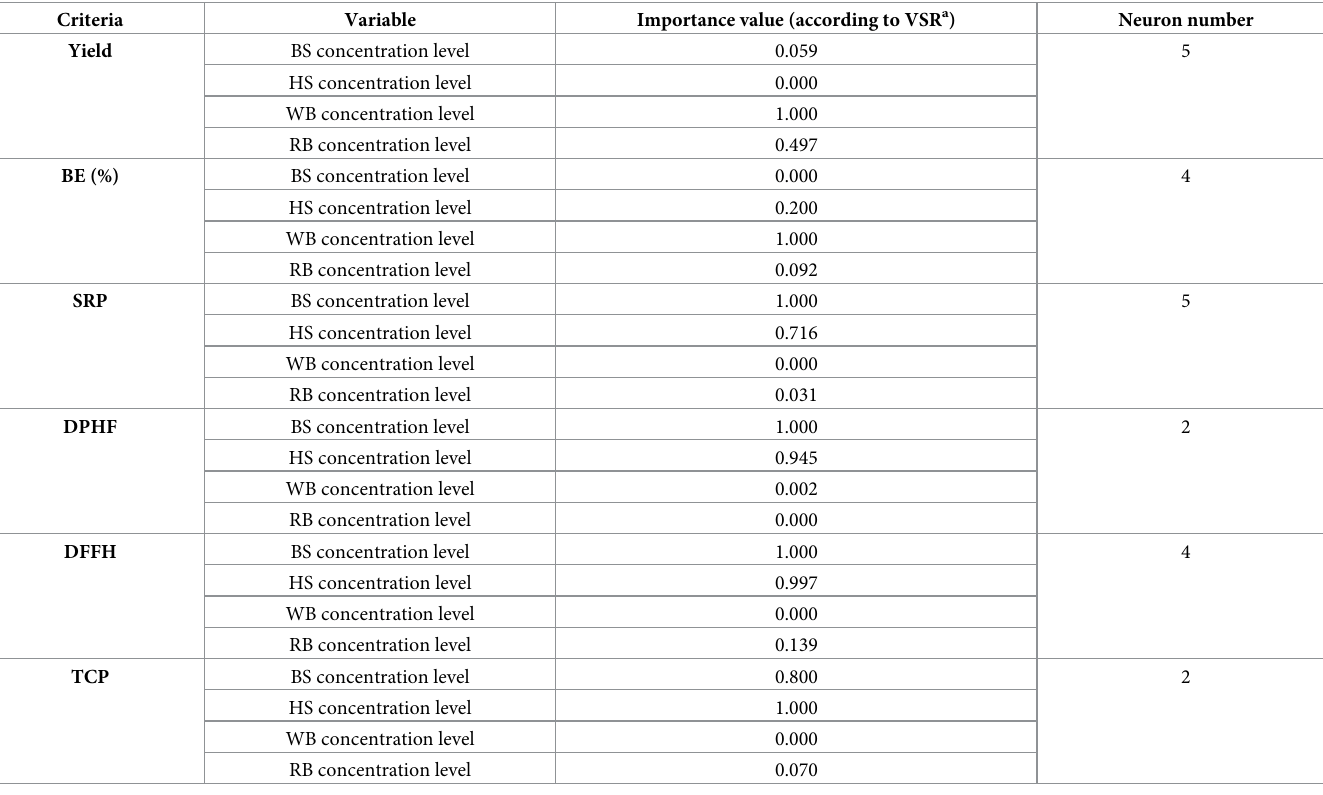
a Relative indication of the ratio between the variable sensitivity error and the error of the model when all variables are available. Calculated VSR values were rescaled within range [0,